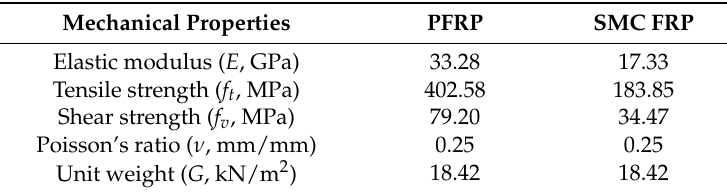
Table 2. Mechanical properties.